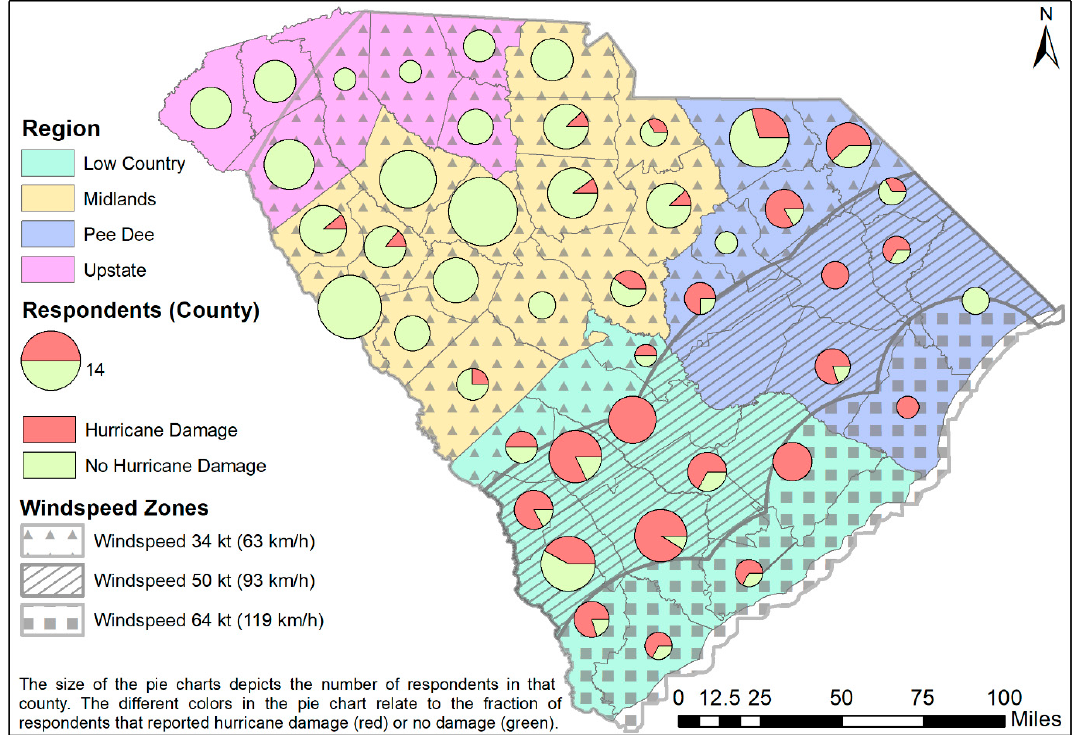
Figure 5. Frequency of reported damage from hurricane Matthew (2016) by county among South Carolina Tree Farmers in 45 counties (June–August 2017 data collection). Three different wind speed zones ranging from 63 km/h to 119 km/h are shown based on six-hourly data from the National Hurricane Center [23].